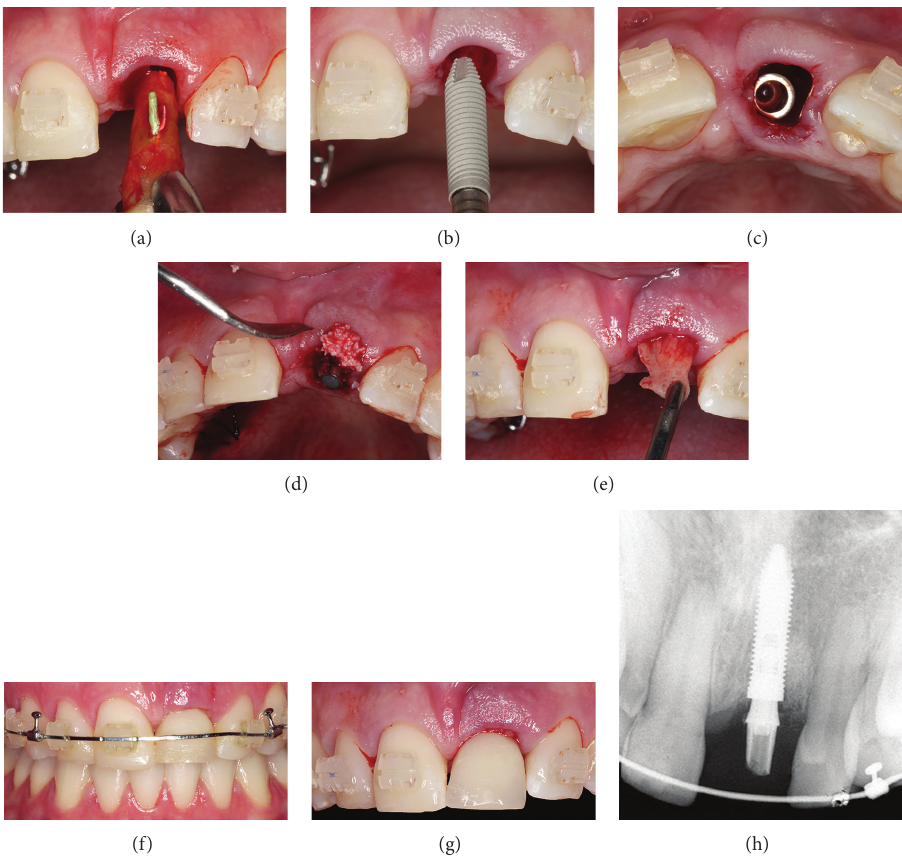
Figure 8: (a) Extrusion of the tooth; (b) implant placement; (c) position of the implant. (d) Bone graft with Bio-Oss; (e) subepithelial connective tissue graft inserted to improve the periodontal tissue biotype. (f) Radiographic examination showing the implant; (g), (h) provisional crown performed in infraocclusion.